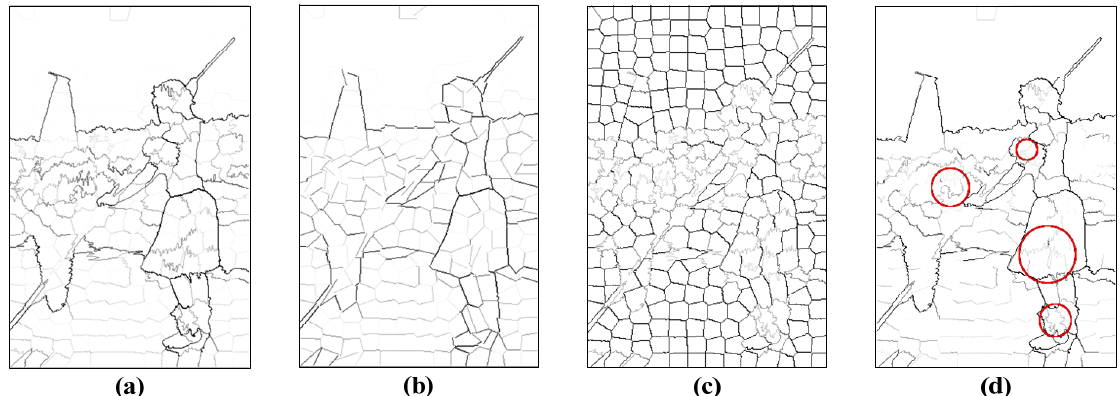
Figure 3. Inherent curvature constancy. ( a ) Contrast energy of the contour candidates computed by low-level cues, using the gray image to represent the contrast energy of each candidate; ( b ) fitted straight line of each candidate with the contrast energy weight; ( c ) inherent curvature constancy evaluation of each candidate; clutter textures tend to be jagged and have small evaluation values; ( d ) modulated weight after inherent curvature constancy evaluation; note that clutter textures marked by red circles have been suppressed obviously compared to